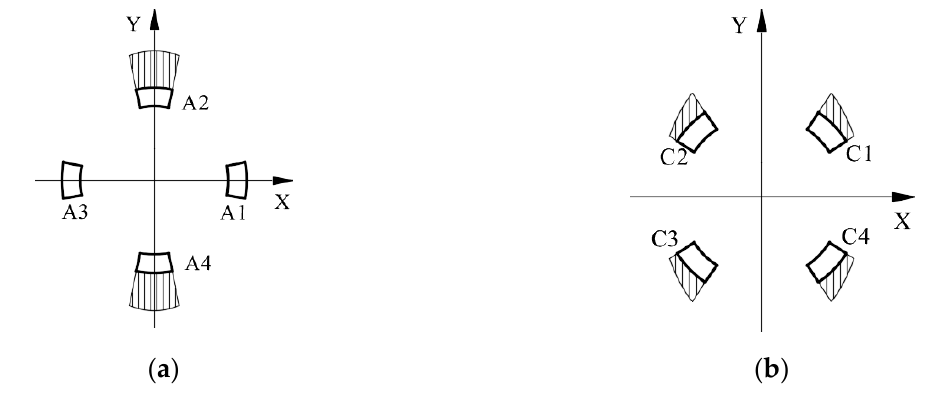
Figure 14. The distribution of shear stress values of the points in the outside surface of layer A and layer C: ( a ) layer A; ( b ) layer C.